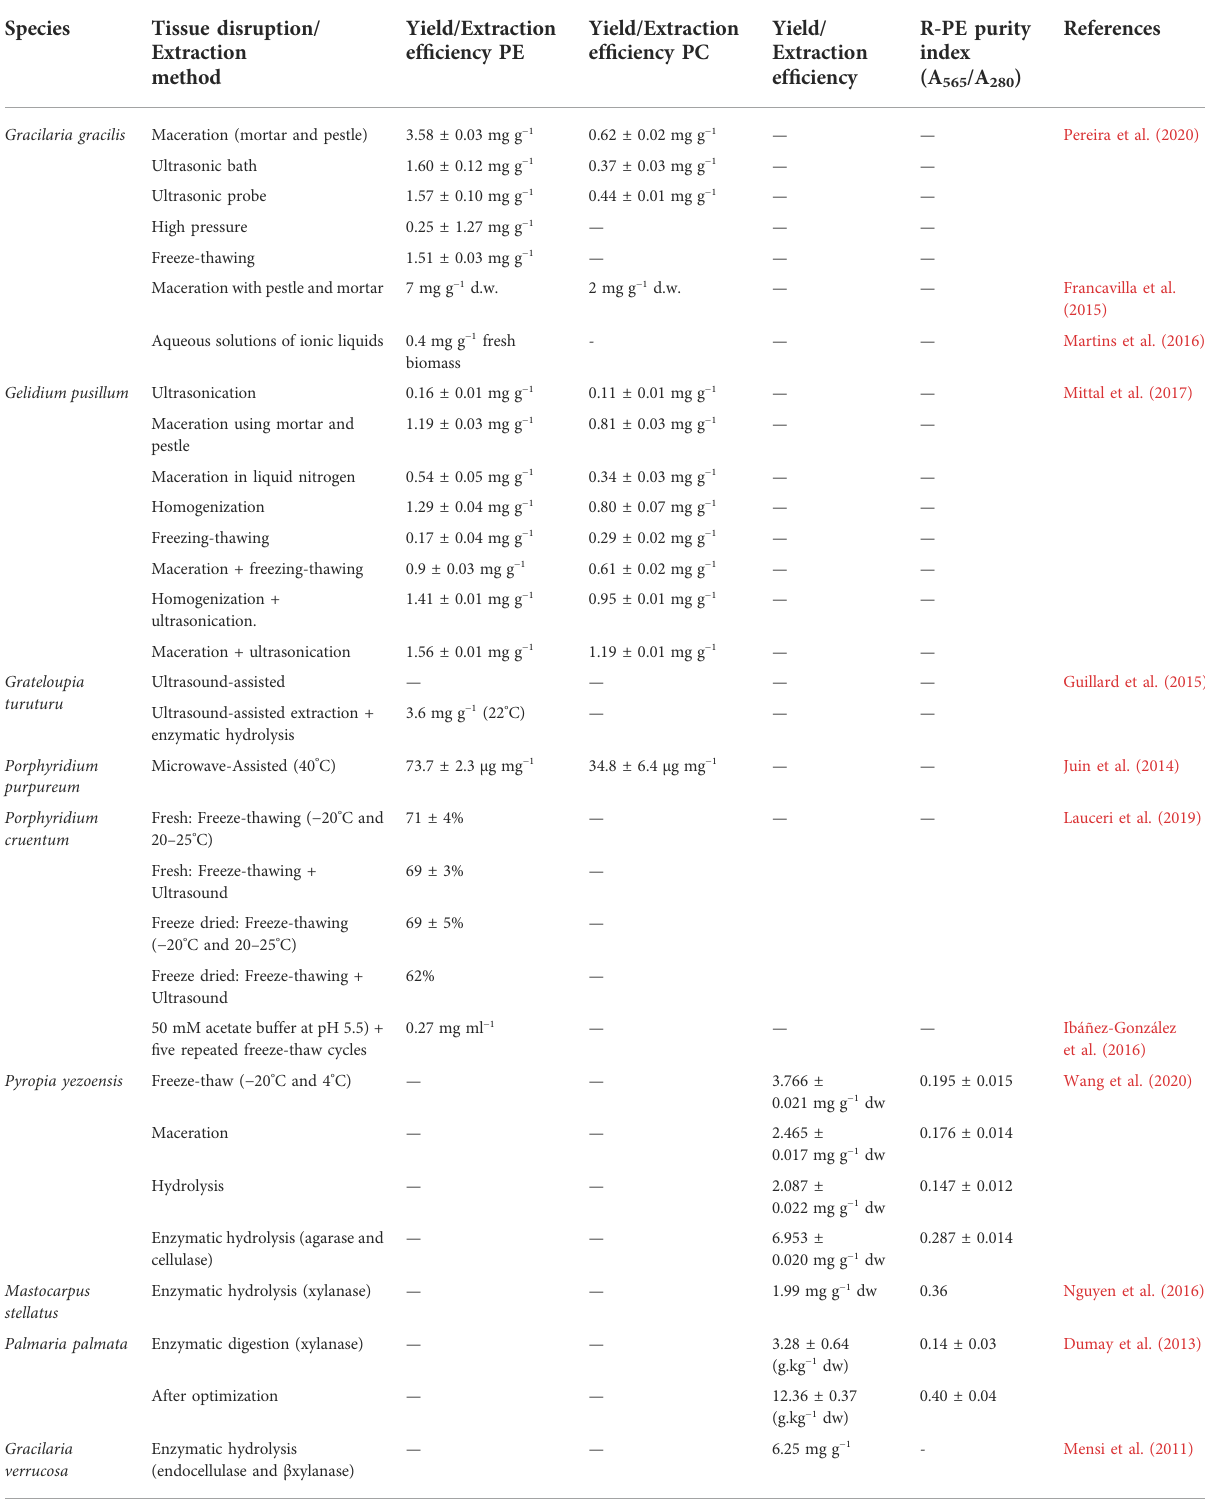
TABLE 2 Extraction methods applied so far to the recovery of phycobiliproteins from macroalgae.